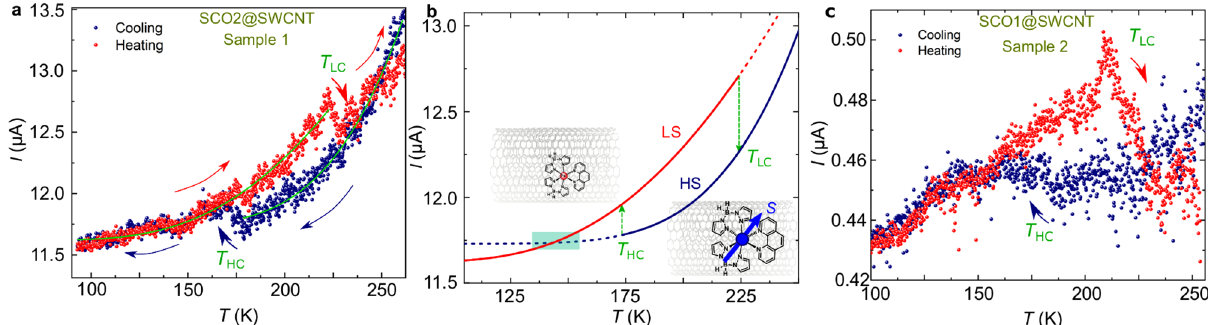
Fig. 3 Electron transport across SCO@SWCNT hybrids. a , c Current I measured at a fi xed bias V = 1 V as a function of the temperature in a SCO2@SWCNT and a SCO1@SWCNT device respectively. The samples are initially cooled down to 90 K (blue curve) and subsequently heated up to room temperature (red curve). The conductance switches between a low-conductance LC and a high-conductance HC state, at temperatures T LC and T HC , respectively, describing a thermal hysteresis. The solid green lines are fi t to the HC and LC states with an Arrhenius model for thermally activated transport. b Theoretical high-spin HS and low-spin LS curves calculated with a thermally activated transport model (Eq. (1)) and the parameters obtained for sample 1. The HS to LS transition may not be visible in the measurement if T HC lies in a temperature range roughly de fi ned by the green square, as seen in some examples in Supplementary Fig.